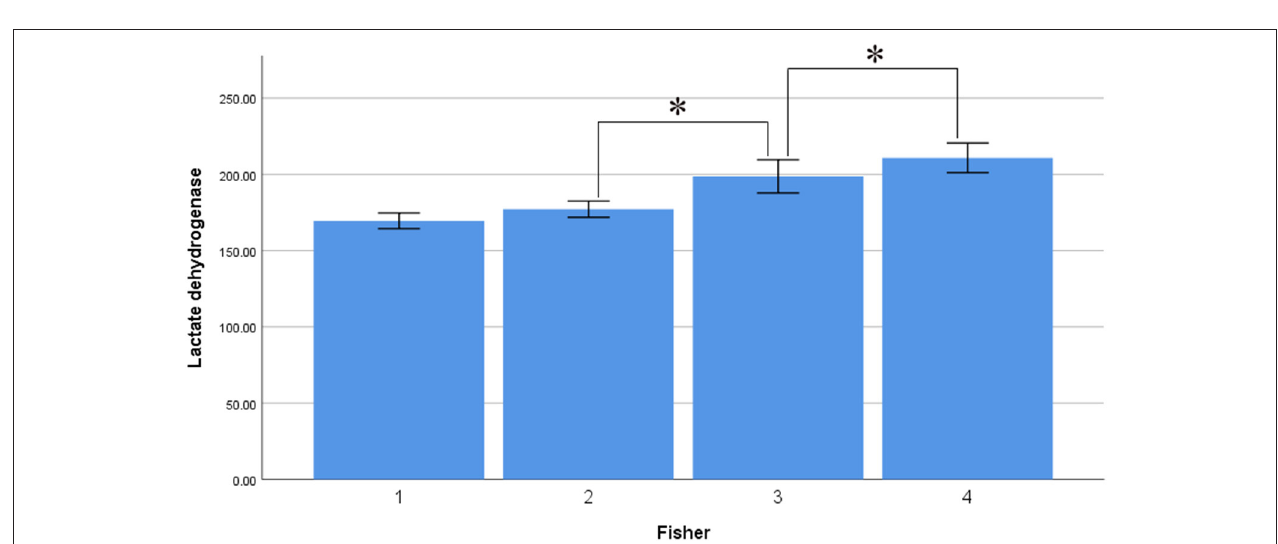
FIGURE 3 | Average level of serum LDH in different Hunt-Hess grade (asterisk represent statistically significant differences).